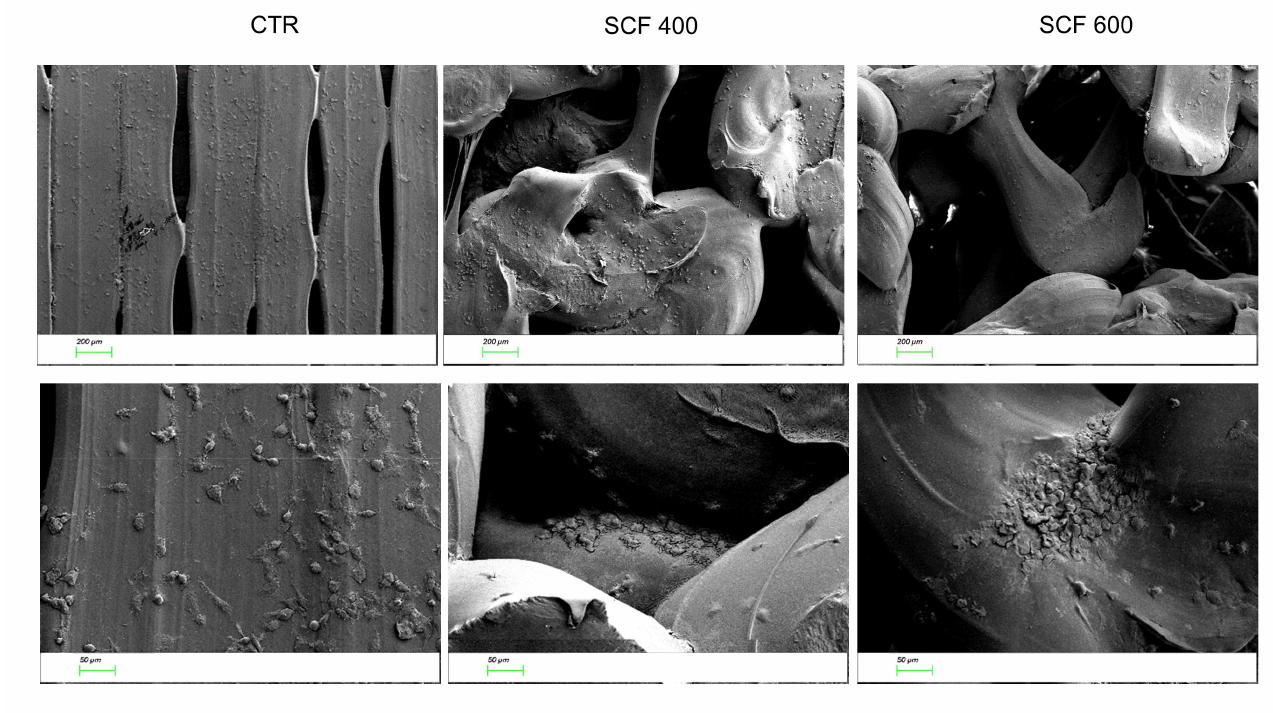
Figure 5. SEM images of the cells seeded on the CTR ( left panel ), SFC 400 ( central panel ), and SFC 600 ( right panel ) scaffolds at 2 different magnifications (50 × top line, 200 × bottom